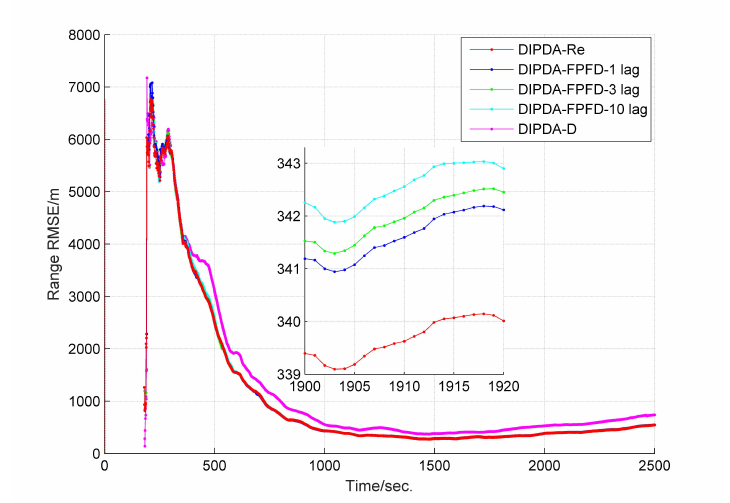
Figure 10. Averaged number of CTTs of DIPDA-D, DIPDA-Re, DIPDA-FPFD with different lags (case 2).